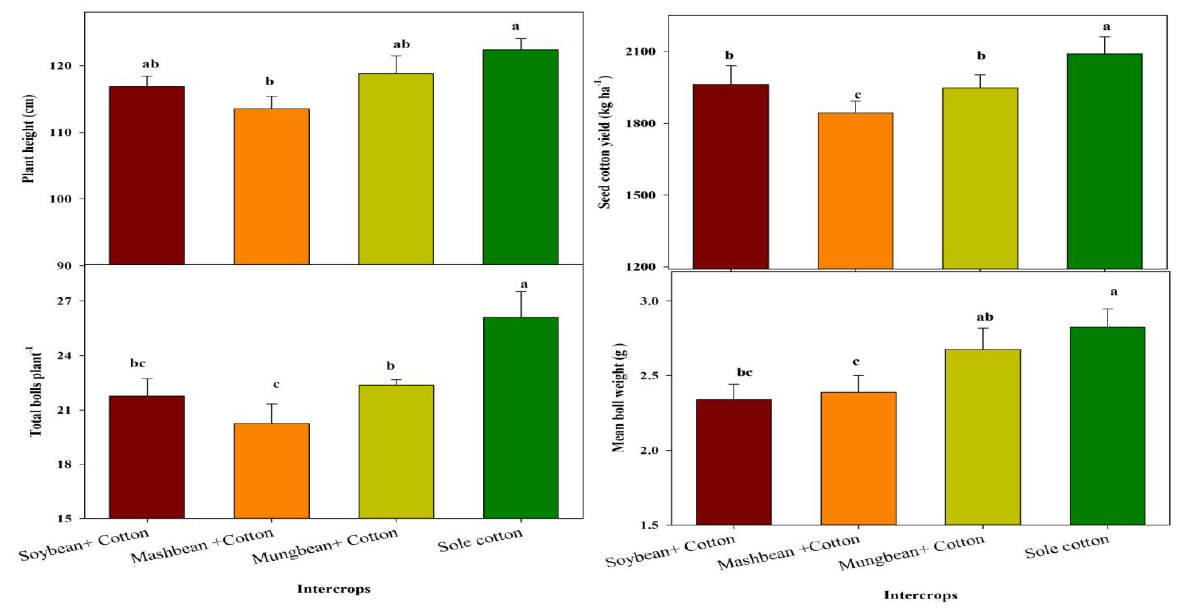
Figure 4. Effect of different legume intercrops on morphological and yield attributes of the cotton crop under arid climatic conditions. (Letters on graph bars “a, b, c, ab, and bc” showed significant differences at p ≤ 0.05). (Tillage systems data are presented in Table 1, as some parameters were not significant, making them difficult to present in graph form.).